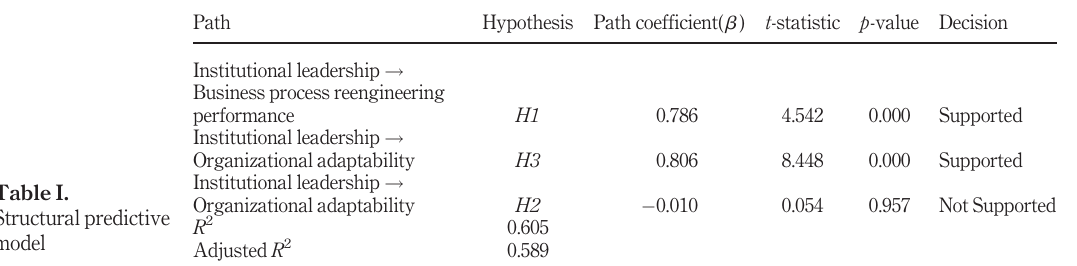
Table I. Structural predictive